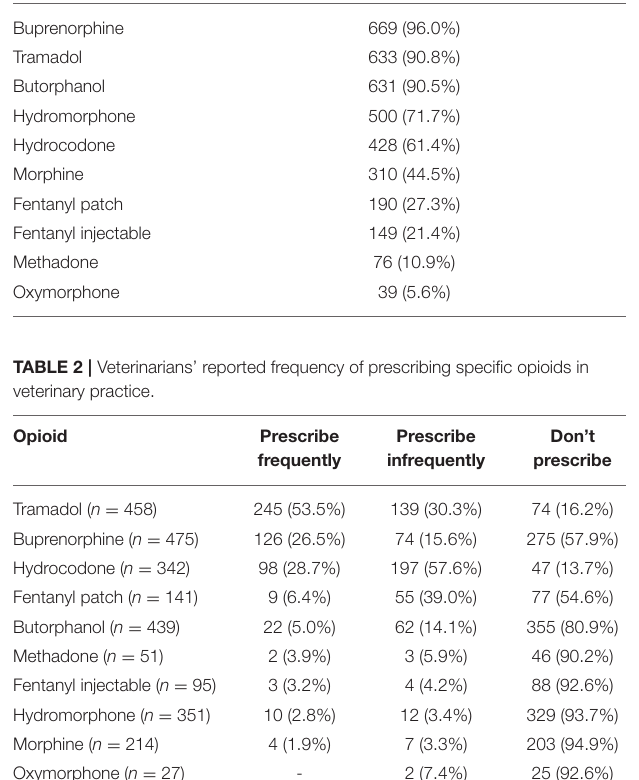
TABLE 3 | Veterinarians’ reported frequency rates of administration of specific opioids in a clinic setting.